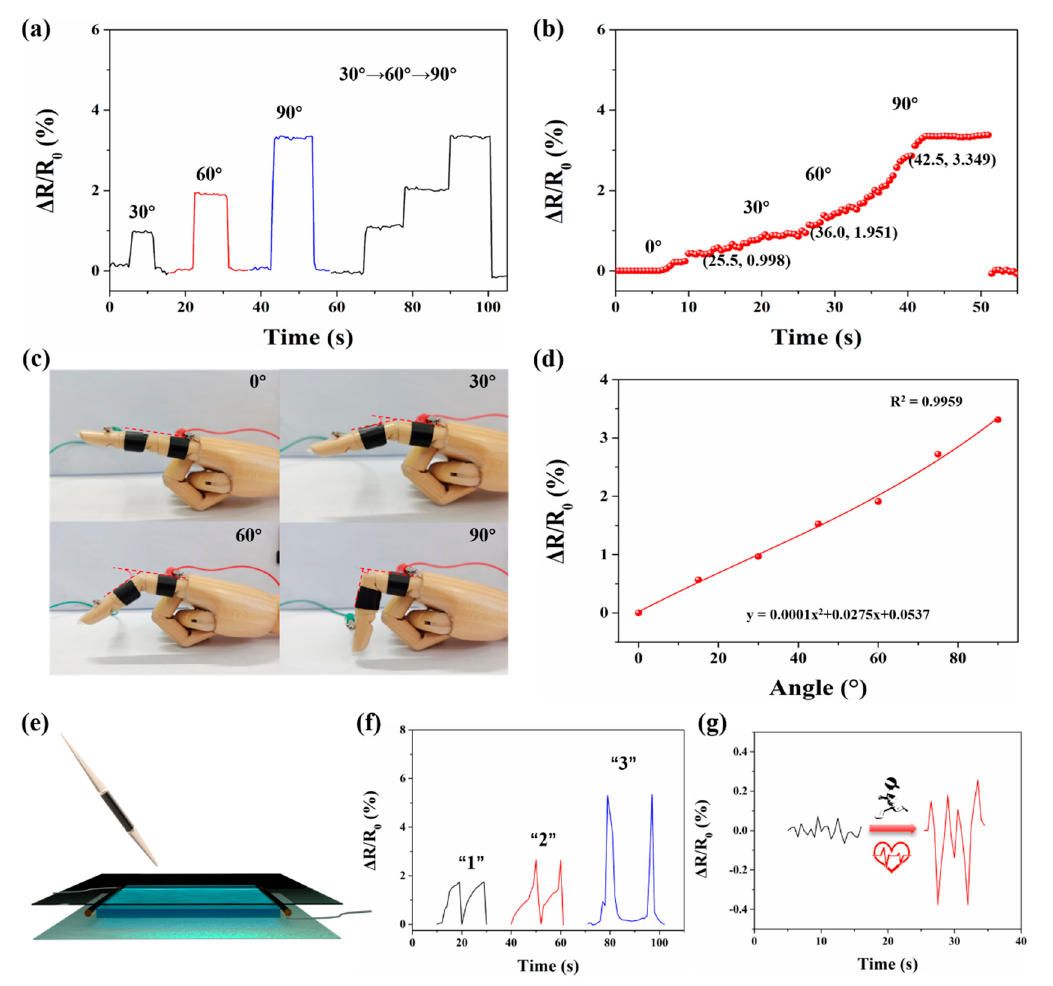
Figure 7. ( a ) RRCs from finger motion of different angles (0 ◦ , 30 ◦ , 60 ◦ , 90 ◦ ). ( b ) RRC values change under continuous and slow bending; ( c ) optical picture corresponding to finger bending; ( d ) corresponding curve of bending angle and RRC value; ( e ) schematic illustration of the setup for handwriting sensing; ( f ) RRCs for “1”, “2”, and “3” written on the PET film; ( g ) RRCs of the pulse beating before and after running for 5 min.